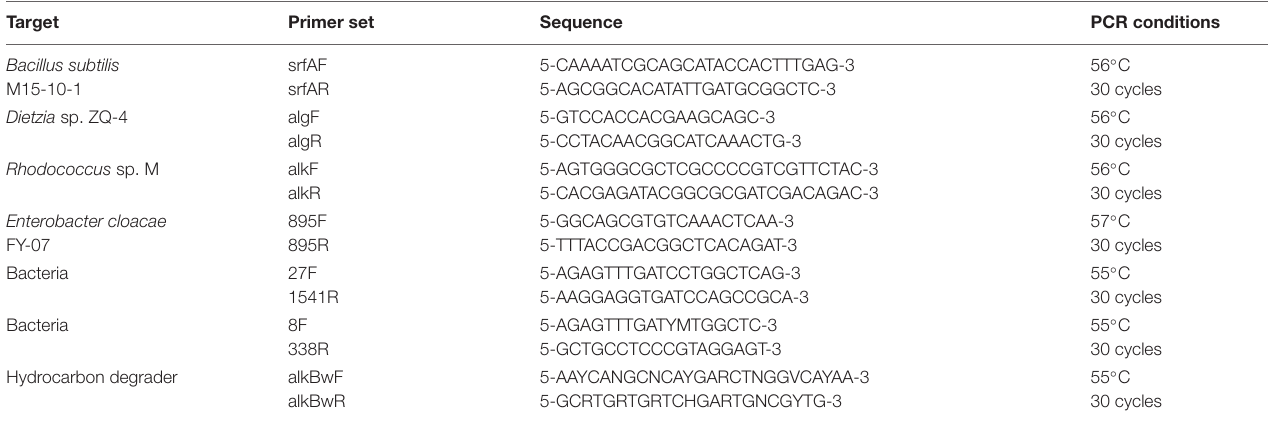
TABLE 1 | Primers used in the present work for